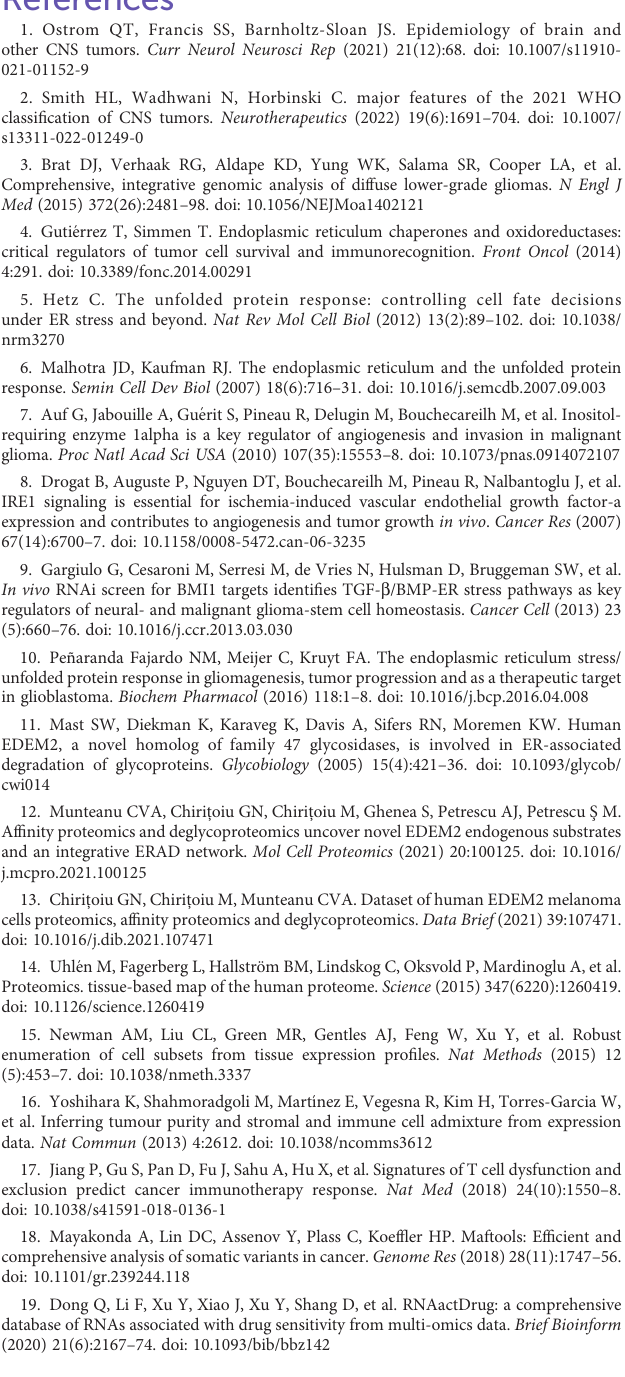
respectively. (D-I) Survival curves of EDEM2 in different pathological statuses, respectively. ***p<0.001. SUPPLEMENTARY FIGURE 2 Model ef fi cacy evaluation of the CGGA cohort. (B) Time-dependent ROC curve of EDEM2. (C) Time-dependent ROC curve model. SUPPLEMENTARY FIGURE 3 Functional enrichment of EDEM2 in the HPA website. (A) Cell lines level. (B) Single-cell level. SUPPLEMENTARY FIGURE 4 EDEM2 in pan-cancer. (A) Expression analysis. (B) Survival